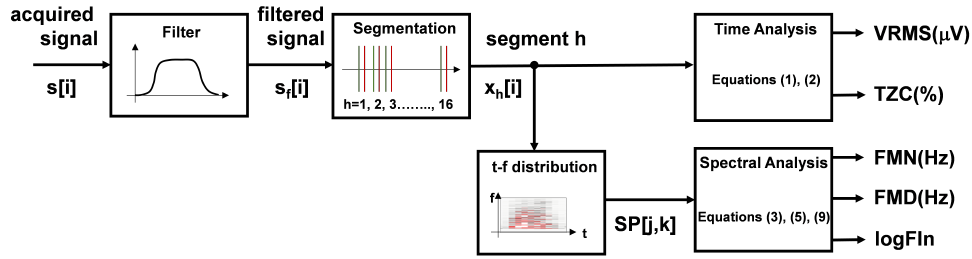
Figure 3. Flow chart of the EMG signals processing. Filtering, segmentation, and